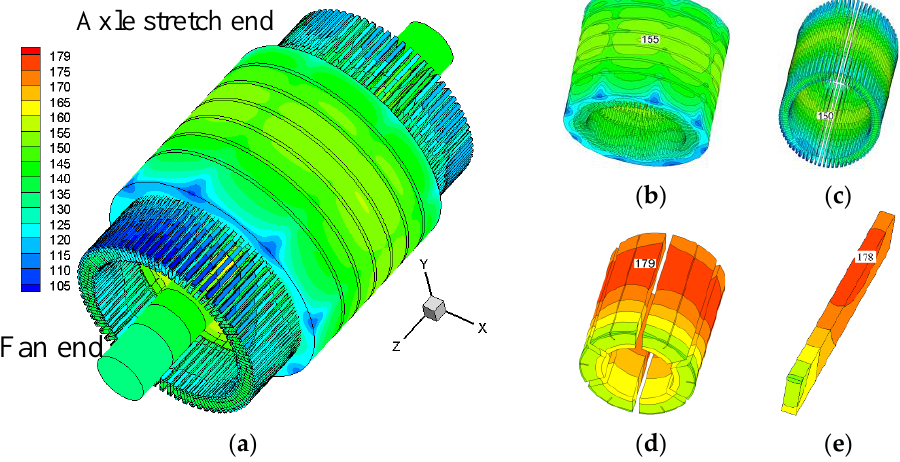
Figure 13. Temperature distribution of each component in the motor with dual ventilation path air-cooled system: ( a ) motor; ( b ) Stator core; ( c ) Stator winding; ( d ) Rotor core; ( e ) Permanent magnet.